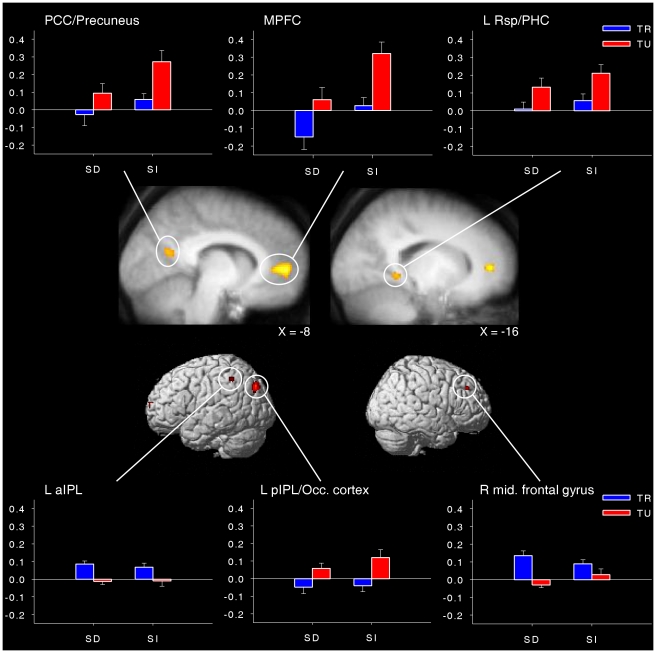
Brain areas associated with the main effect of task-relatedness.Regions are displayed at p<0.001, uncorrected for multiple comparisons with a minimum cluster size of 15 voxels. Bar graphs illustrate the mean parameter estimates (± standard error of the mean) for each cluster. SD = stimulus-dependent, SI = stimulus-independent, TR = task-related, TU = task-unrelated, L = left, R = right, MPFC = medial prefrontal cortex, PCC = posterior cingulate cortex, aIPL = anterior inferior parietal lobe, pIPL = posterior inferior parietal lobe, Occ. cortex = occipital cortex, Rsp = restrosplenial cortex, PHC = parahippocampal cortex.